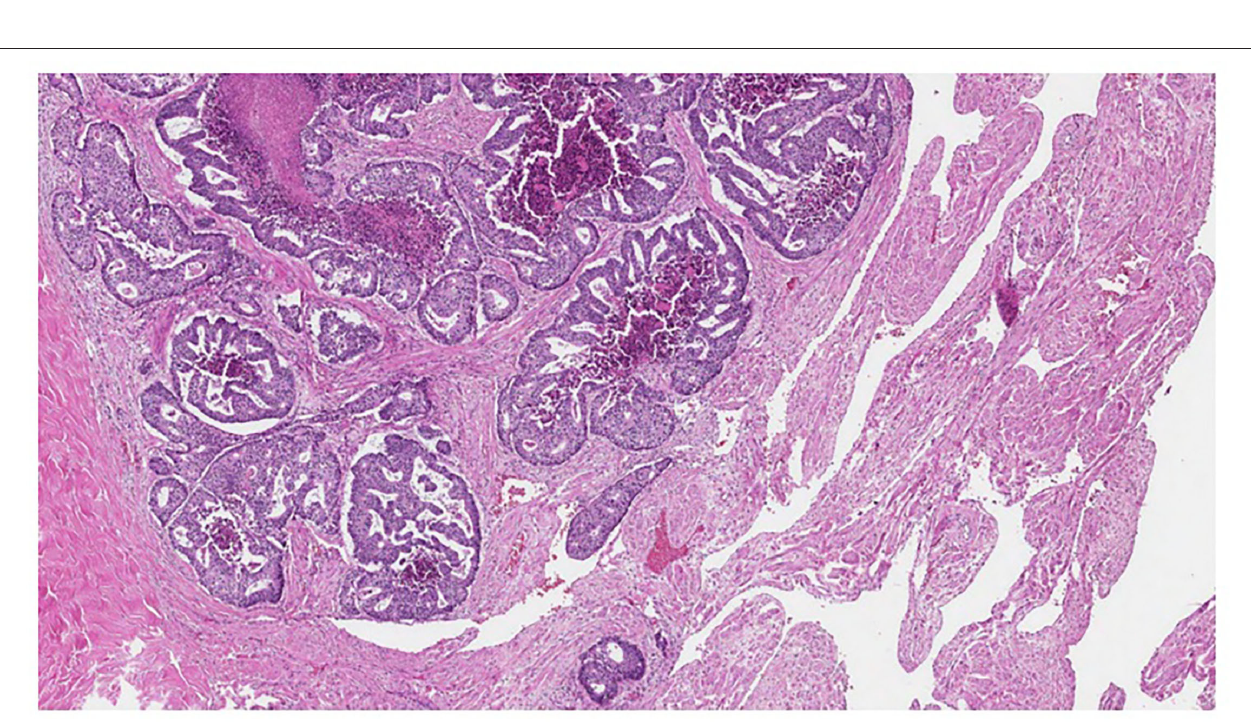
FIGURE 2 | Cribriform tumor structures in the corpus cavernosum (HE, original magnification ×